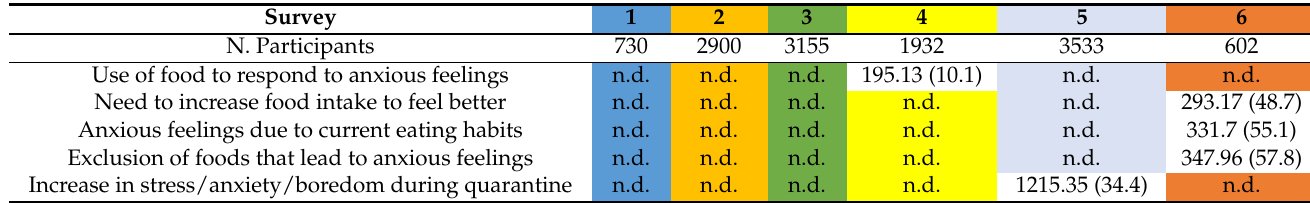
Table 5. Food as an antidote to anxiety, absolute value (N.) and (%) on the total. Survey